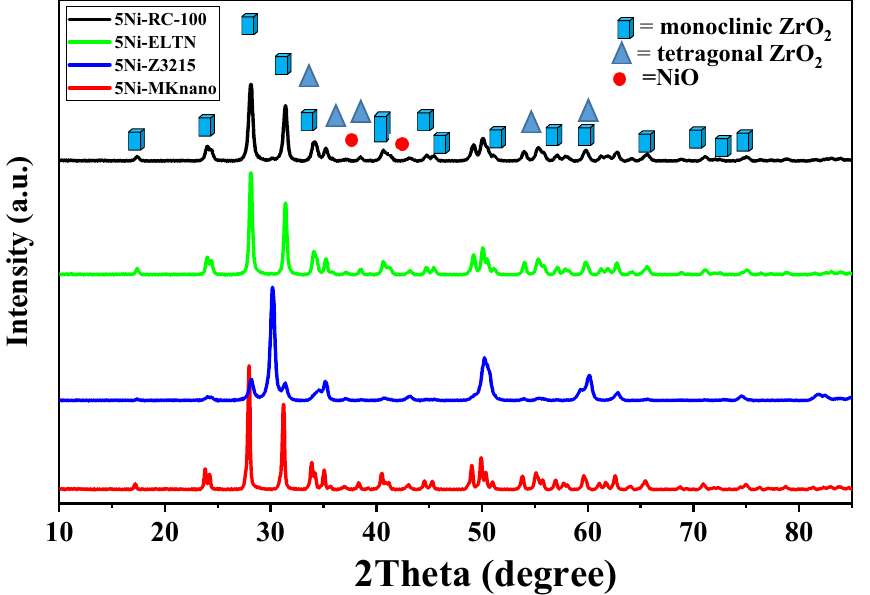
Figure 1. XRD of different sources of zirconia-supported Ni samples.